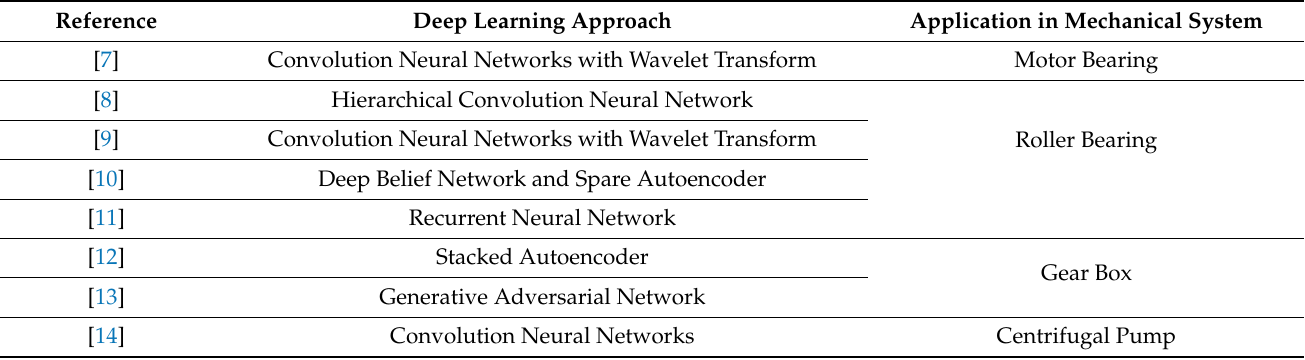
Figure 1. Application of deep learning before and after DNN utility. Table 1. Implementation reference of deep learning methods in mechanical applications.